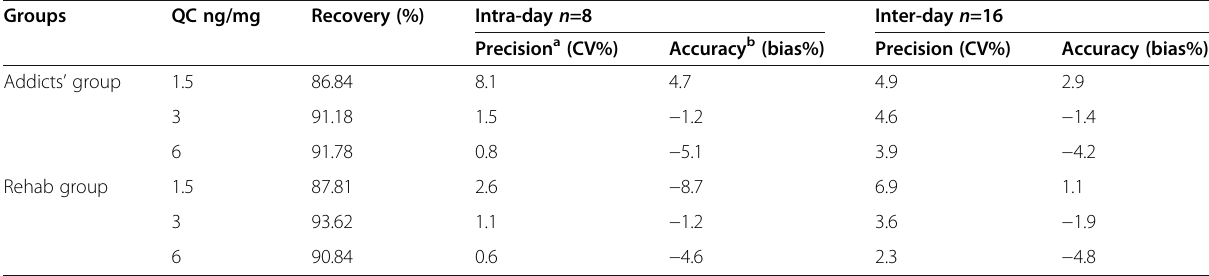
Table 2 Results of accuracy, precision, and recovery for method validation using quality control (QC) samples